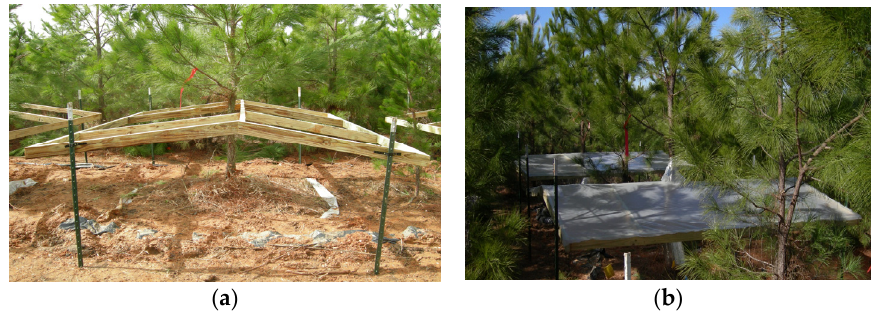
Figure 2. ( a ) Photograph of individual excluder during construction and ( b ) photograph of excluders